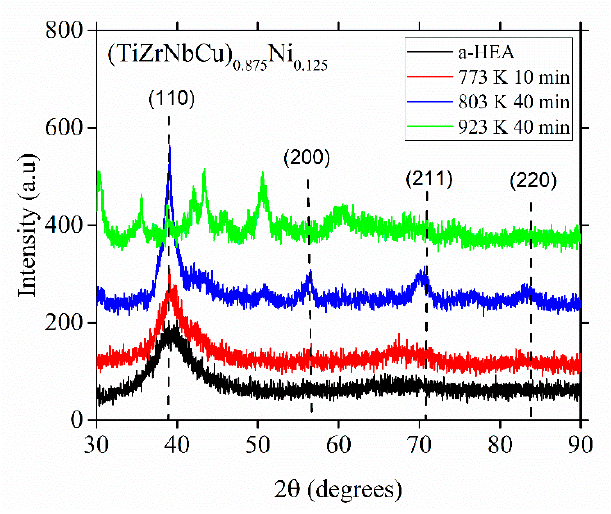
Figure 9. XRD patterns of as-cast (a-HEA) TiZrNbCu) 0.875 Ni 0.125 sample and TiZrNbCu) 0.875 Ni 0.125 samples annealed at specified temperatures. Vertical dashed lines denote positions of maxima in β - Ti.